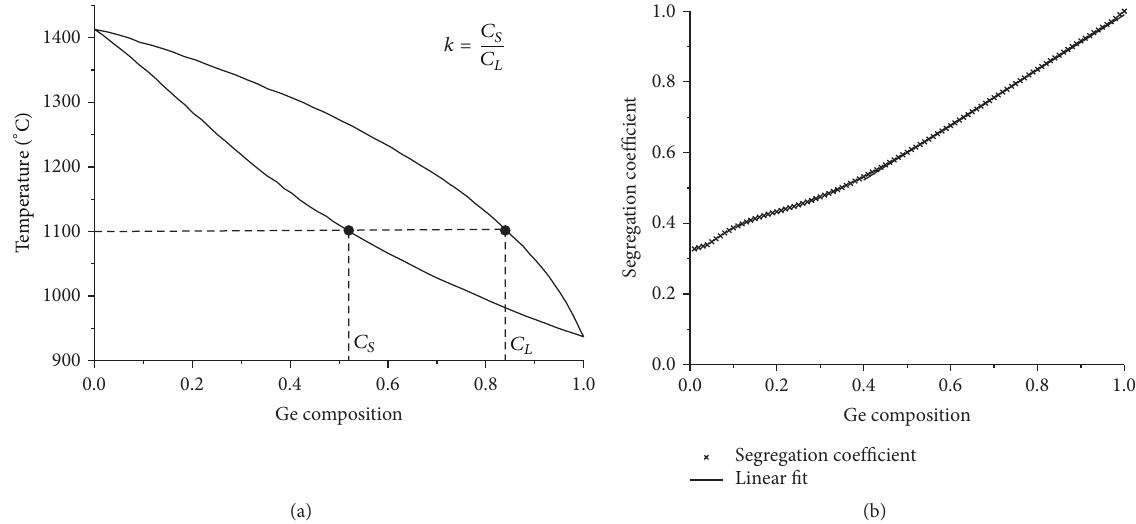
Figure 5: SiGe segregation coefficient. (a) Calculating the segregation coefficient from the phase diagram and (b) SiGe segregation coefficient as a function of Ge composition. A linear fit has been applied between Ge compositions of 0.4 and